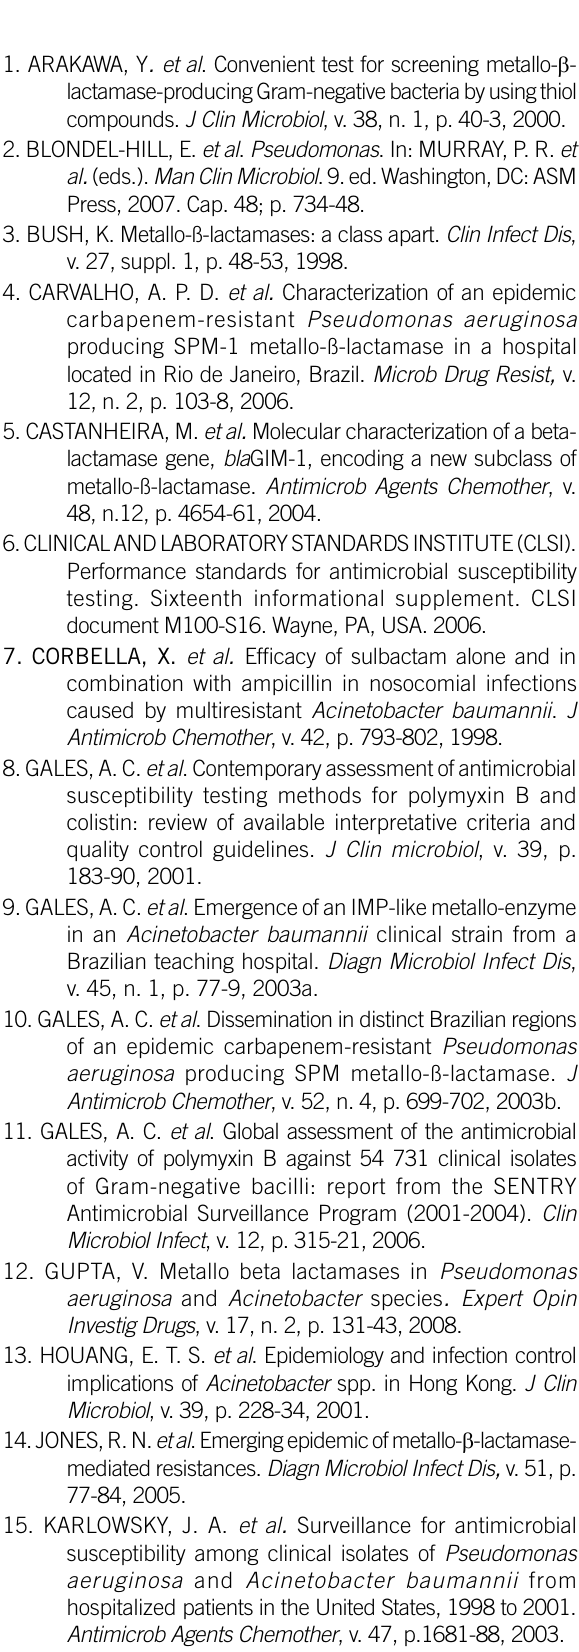
• v. 45 • n. 3 • p. 177-184 • junho